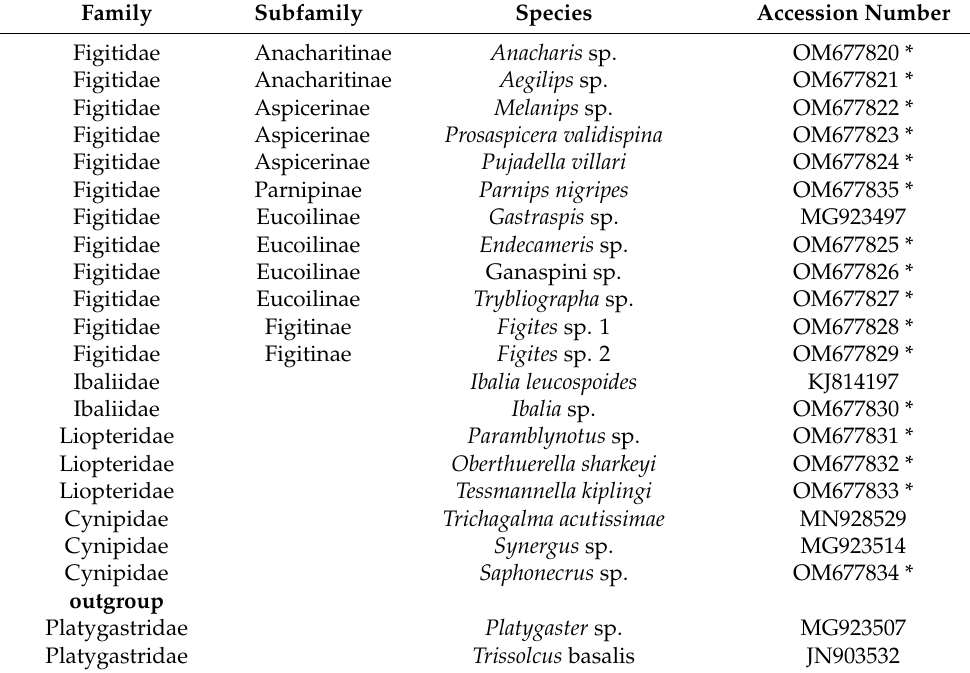
Table 1. Information of mitochondrial genomes used in phylogenetic analysis. Family